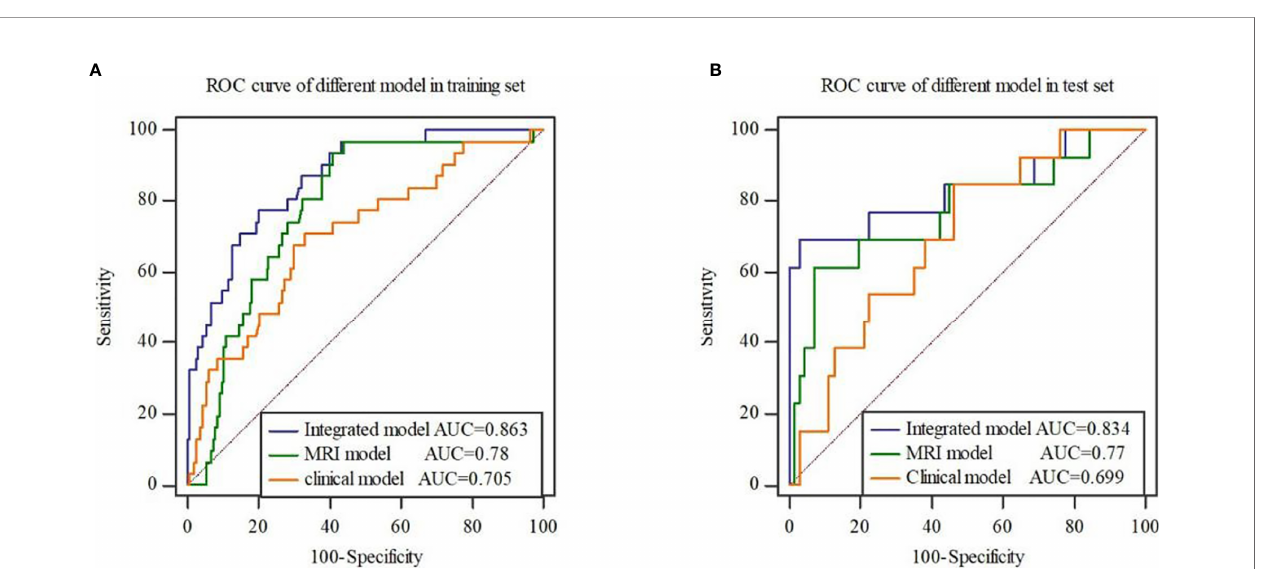
FIGURE 5 | ROC curves of three models in the training set (A) and test set (B) . The results show that the integrated model has the highest AUC